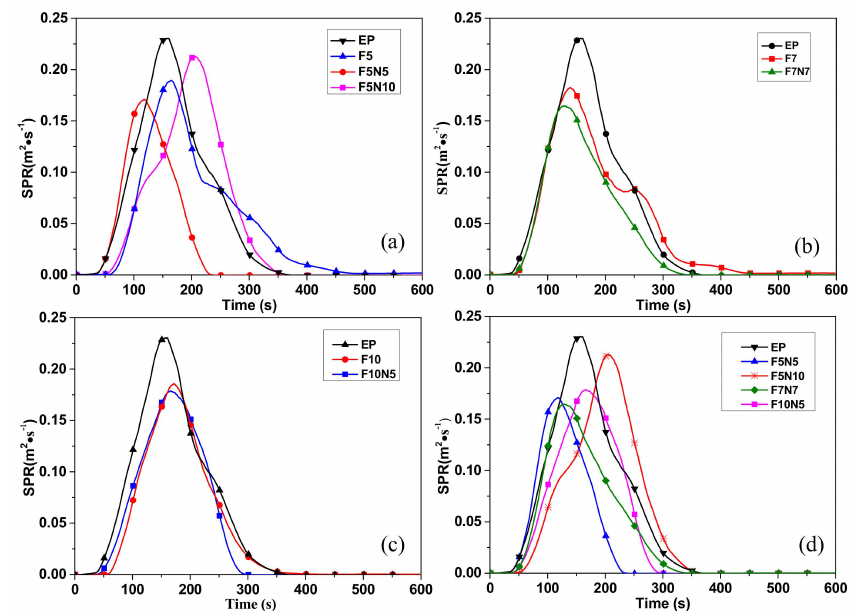
Figure 2. Rate of smoke production (SPR) of di ff erent samples. ( a ) SPR of epoxy resin (EP), F5, F5N5, and F5N10; ( b ) EP, F7, and F7N7; ( c ) EP, F10, and F10N5; and ( d ) EP, F5N5, F5N10, F7N7, and